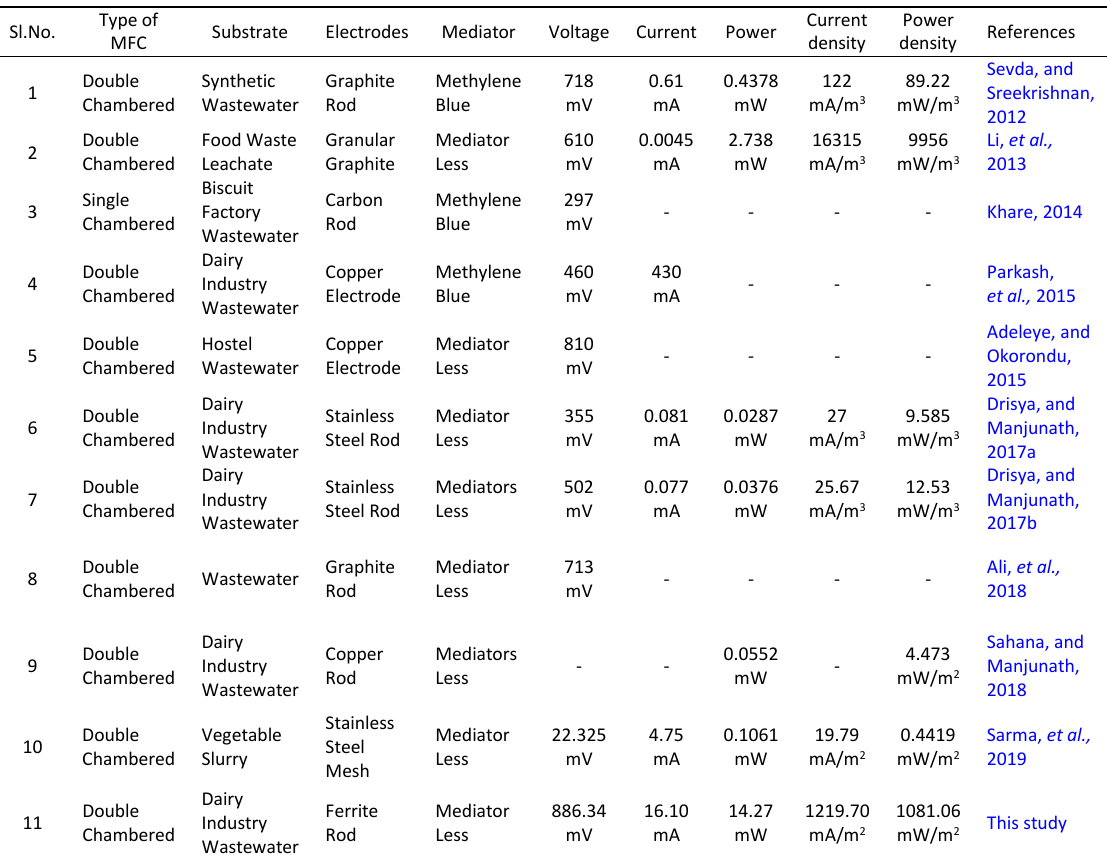
Table 9 Comparison of voltage, current, power, current density and power density from various industry wastewaters using MFC